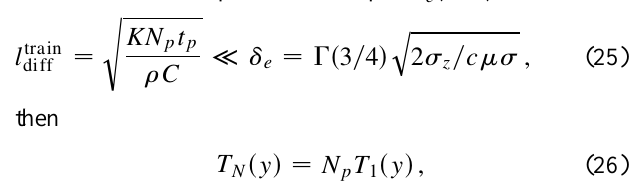
FIG. 7. Plot of the exact value of a as a function of y .